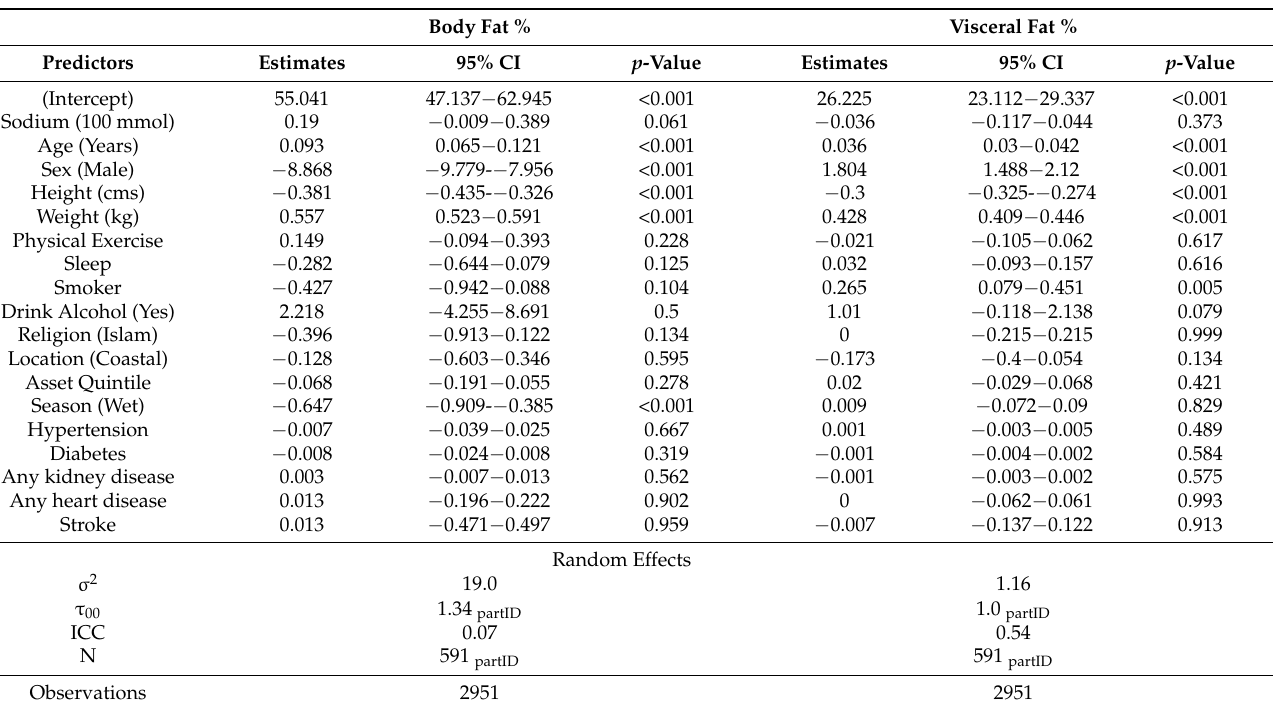
Table 11. Association between 24 h urinary sodium and 10th percentile body fat percentage and visceral fat